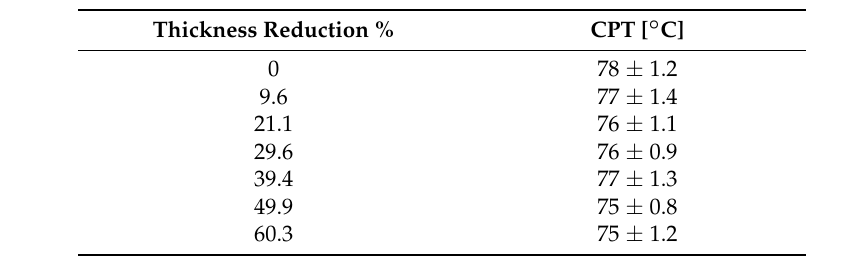
Figure 9. CPT curves of unwelded sheet metal. Table 3. CPT of the welded sheet metal.